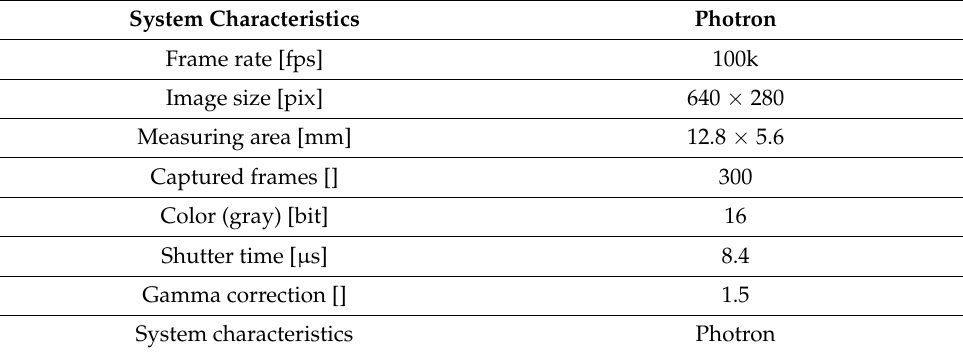
Table 2. Relevant parameters of the detection